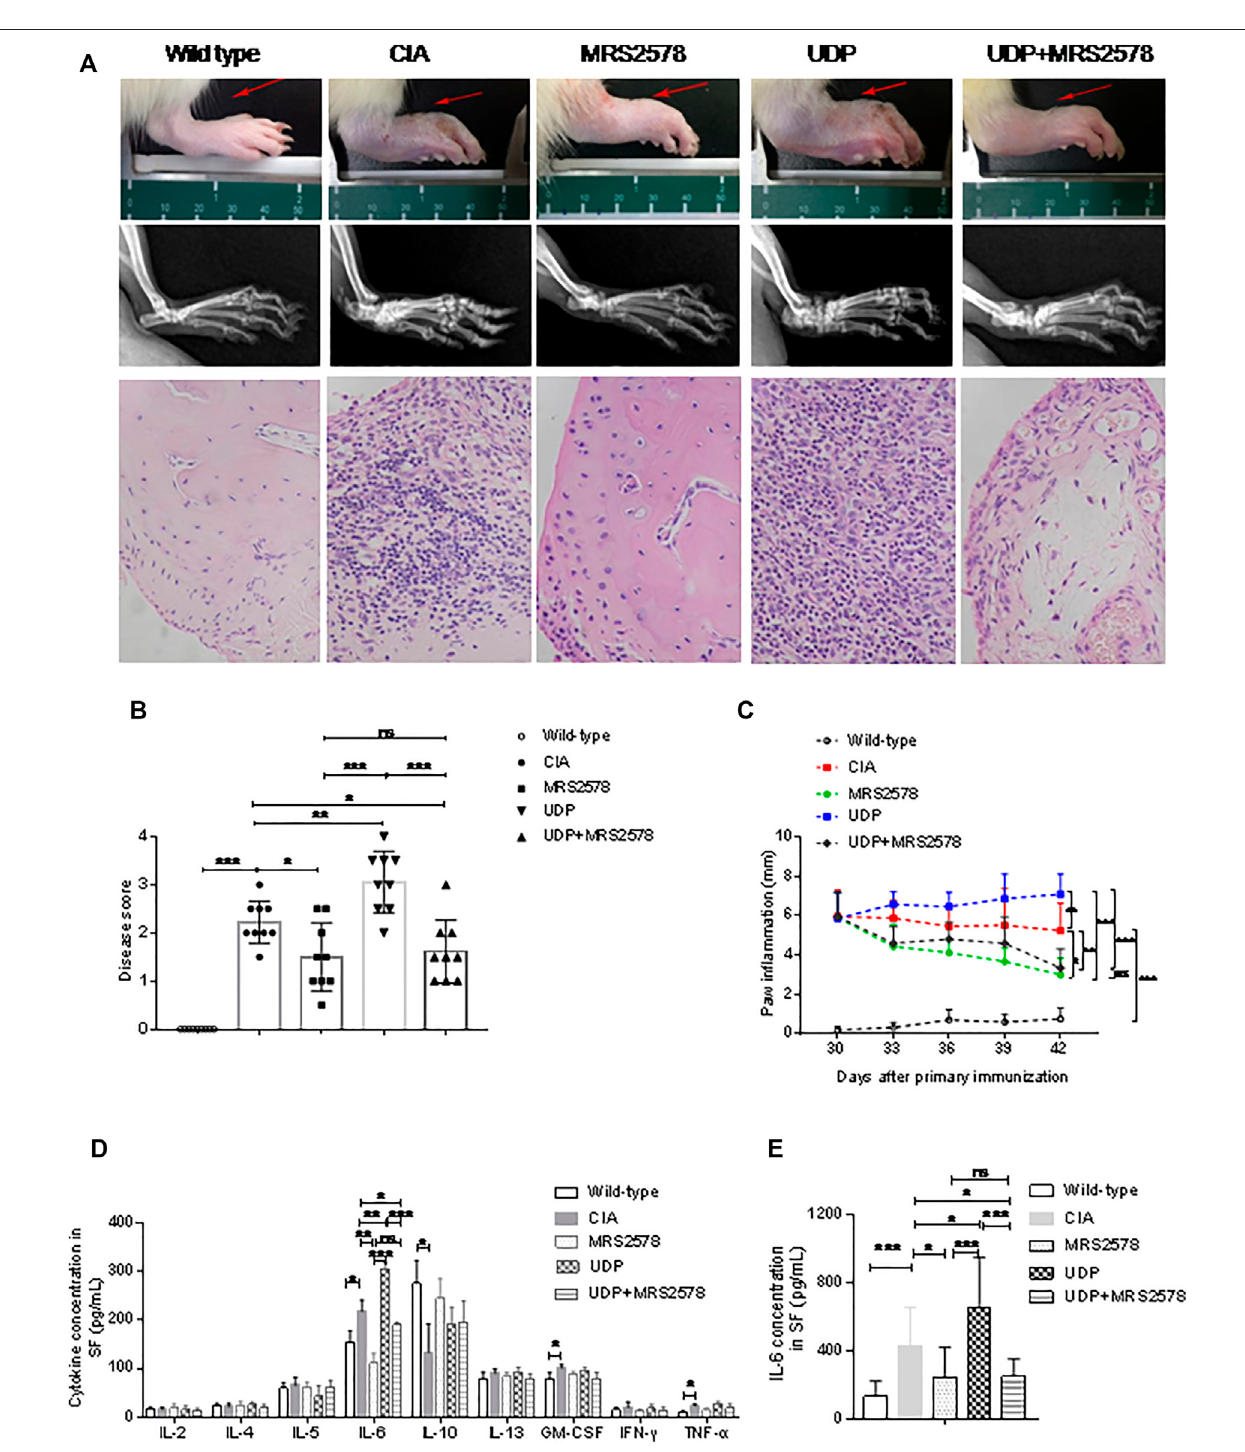
FIGURE 7 | The effect of MRS2578 on CIA rats treated with UDP. (A) X-ray images and histochemical staining images of joint in fl ammation. (B) Disease scores were quanti fi ed based on histologic evidence. (C) In fl ammation curve analysis based on paw in fl ammation. (D) Cytokine levels in synovial fl uids using a fl ow cytometric bead assay. (E) IL-6levels insynovial fl uids were assessed using ELISA. X-rayimages, joint tissues, peripheral blood and synovial fl uids were collected 20 days after the fi rst UDP injection (3 days after the last UDP injection/7 weeks after the fi rst collagen injection). Each groups had nine rats, SF: synovial fl uids. * p < 0.05, ** p < 0.01 and *** p <